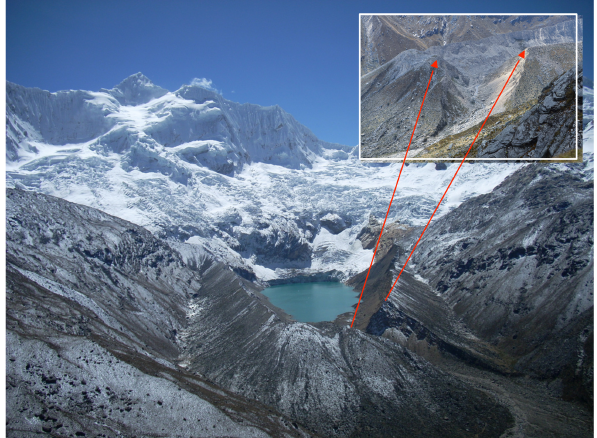
Figure 2. Front views of Lake Palcacocha and the breach of the 1941